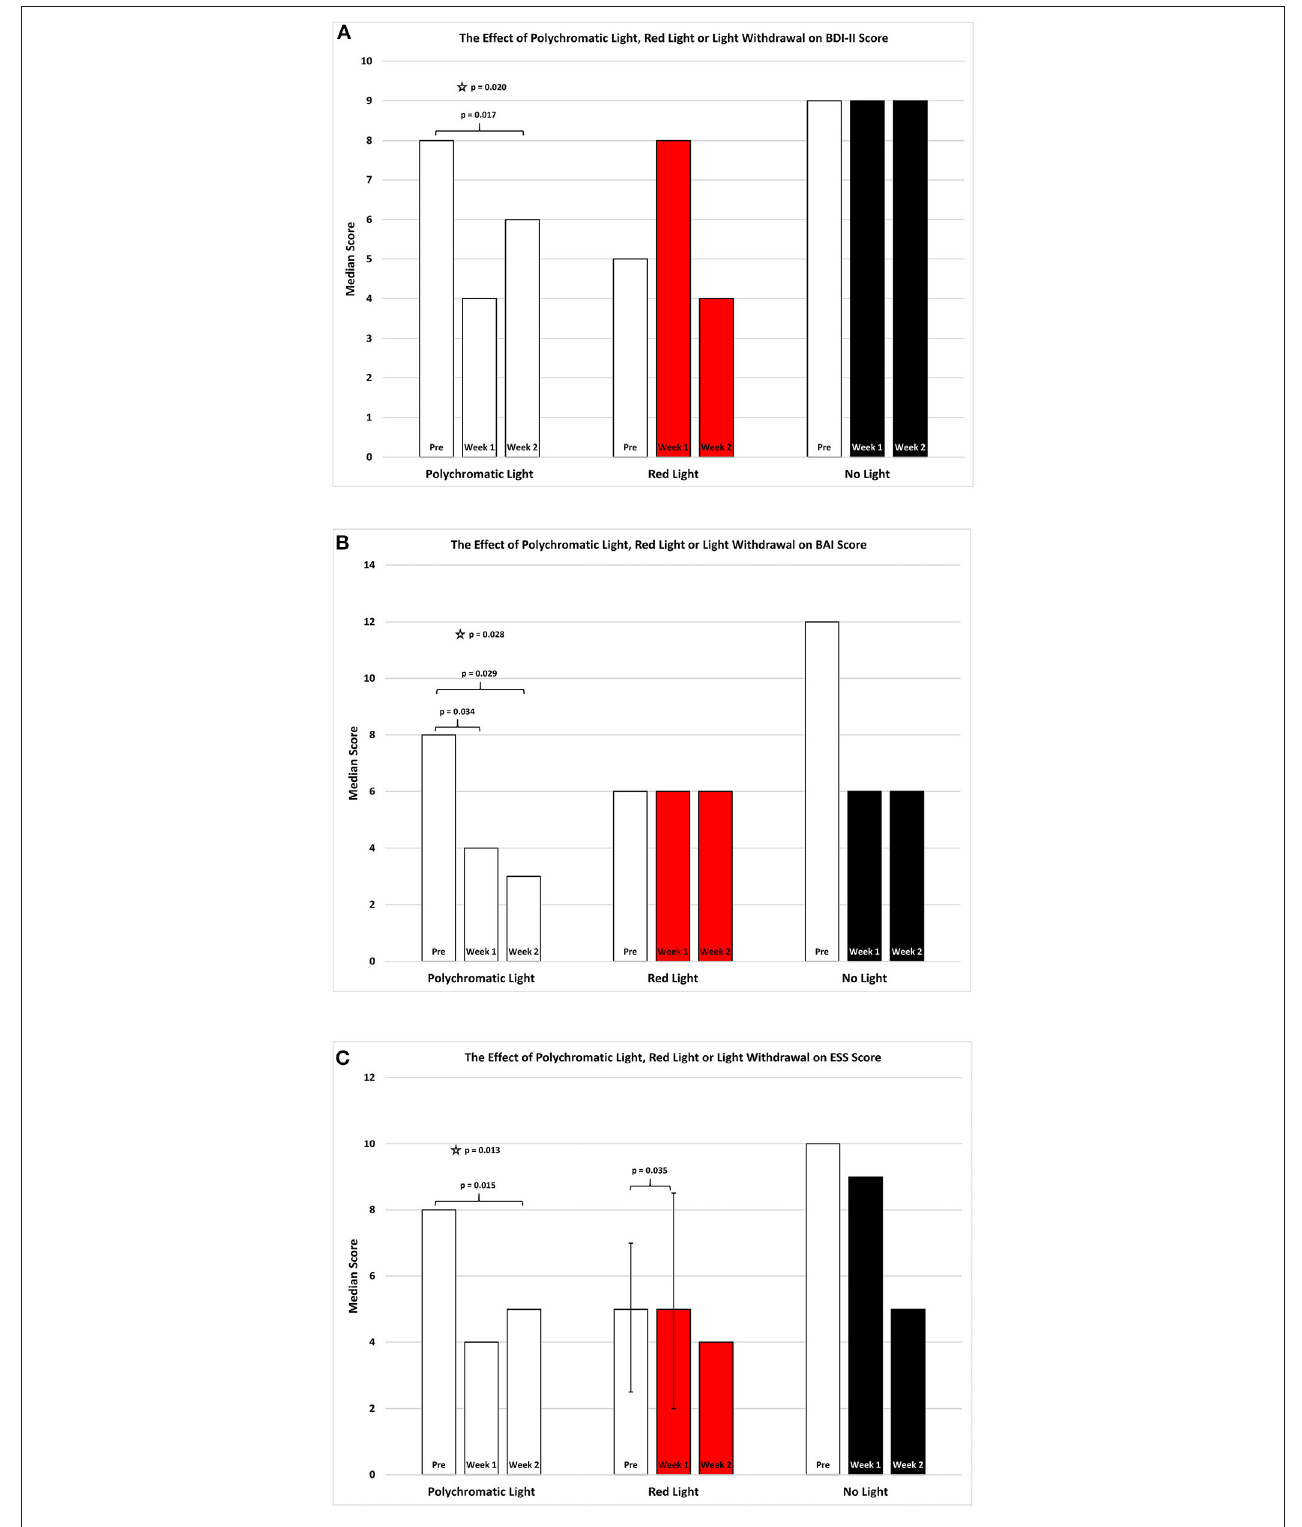
FIGURE 4 | The effect of continued daily exposure to polychromatic light, red light or withdrawal of polychromatic light on the BDI-II (A) , BAI (B), and the ESS (C) is expressed as the median score for each group after 3 assessments over a 2 week period. The pre-score served as the baseline and was obtained when the